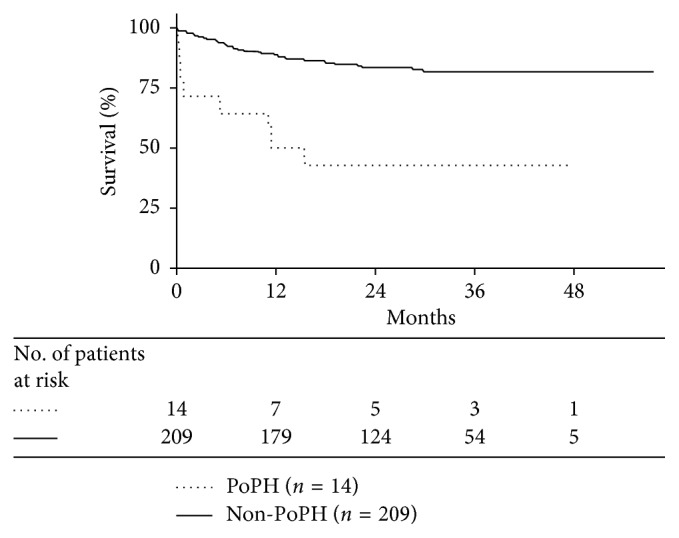
Kaplan–Meier survival curve. There was a lower survival in patients with PoPH compared to patients without PoPH (p < 0.001 by the log-rank test). The number of patients at risk at the different times of the follow-up period is reported below the horizontal axis.